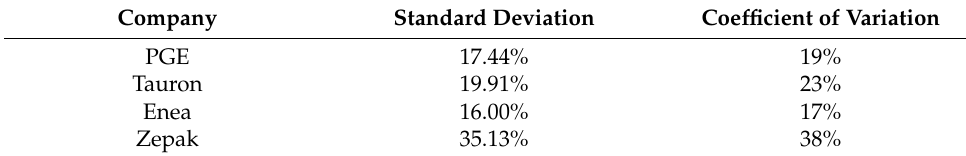
Table 6. Coefficients of variation and standard deviations for quotation changes of the surveyed companies.